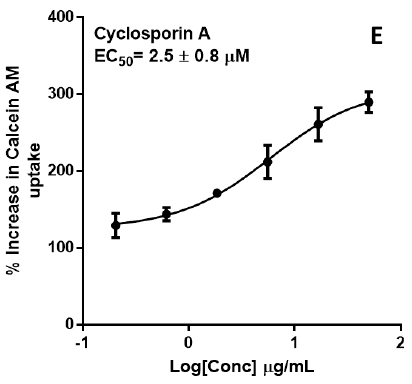
Figure 8. Dose-response curves of P-gp inhibition determined by calculating the percent uptake of calcein-AM into hMDR1-MDCKII cells in the presence of ( A ) P. amarus ; ( B ) M. charantia ; ( C ) A. muricata ; ( D ) T . diversifolia and ( E ) cyclosporin A, the positive control.